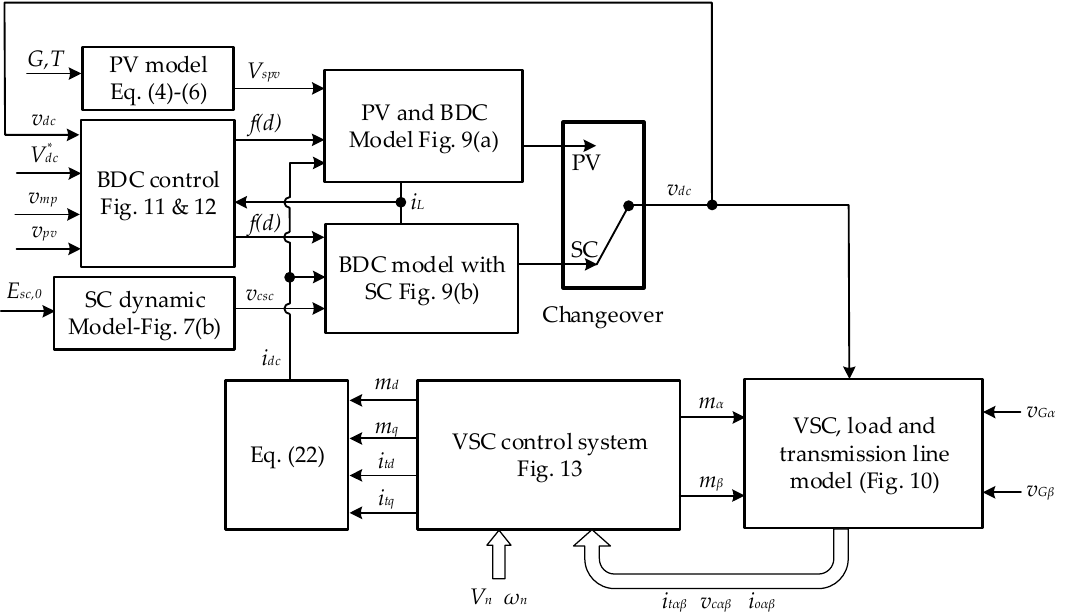
Figure 14. Nonlinear mathematical model of the proposed PVSC system.